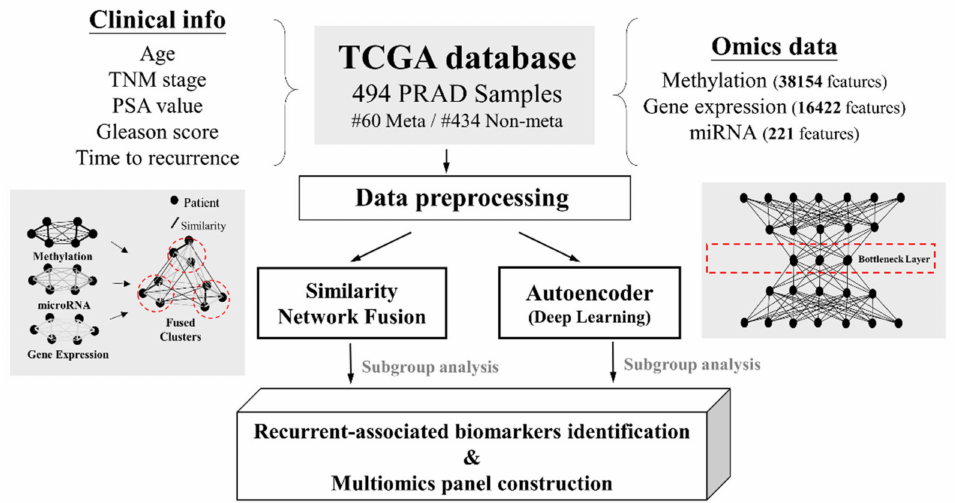
Figure 1. Overview of the study workflow. TNM, tumor, node, metastasis status; PSA, prostate- specific